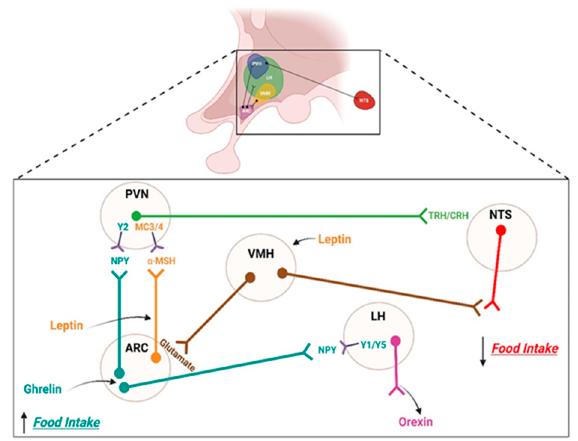
Figure 1. The homeostatic control system of feeding. Increased food intake is triggered by the activa- tion of agouti-related protein (AgRP) and neuropeptide Y (NPY) orexigenic neurons by ghrelin action. These neural activations consequently inhibiting the paraventricular nucleus (PVN) anorexigenic neurons and activating the neurons present in the lateral hypothalamus (LH). On the other hand, hormones such as leptin, which stimulates the glutamatergic neurons of the ventromedial nucleus